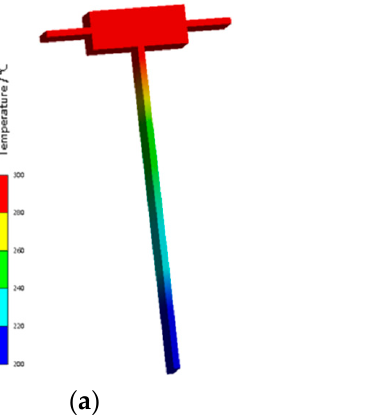
( c ) Figure 6. Effect of feature size on the heat transfer parameters: ( a ) Measured temperature field of cantilever beam test specimens with a width of 50 µm; ( b ) fitting results of the heat transfer pa- rameters; ( c ) variation of the heat transfer parameters with characteristic size. The experimental results indicate that the convective heat transfer coefficient grad- ually increases with the decrease in the device size, which represents a gradual increase in the capability to dissipate heat. Natural convective heat transfer mainly caused by density difference is characterised by the size of the Grashchev number Gr (containing buoyant force). The smaller the feature size of the solid beam is, the smaller the volume of